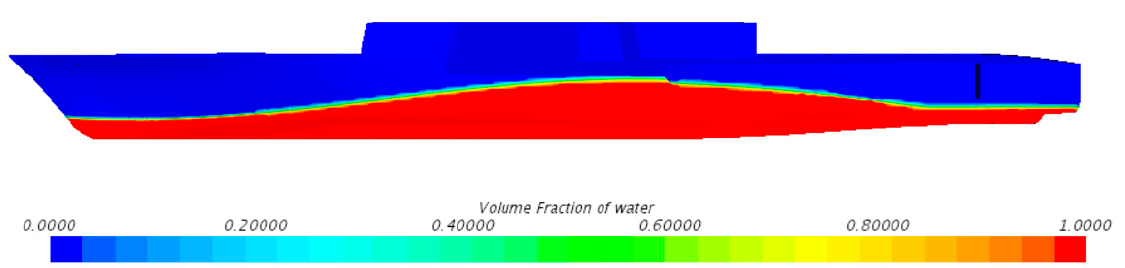
Figure 2. Water volume fraction profile around the hull surface.